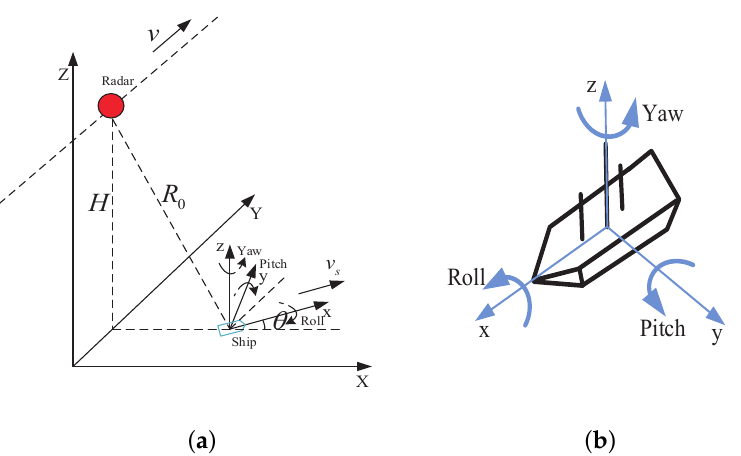
Figure 1. ( a ) The geometric relationship between the radar and the ship target. ( b ) 3-D rotational motion model of the ship